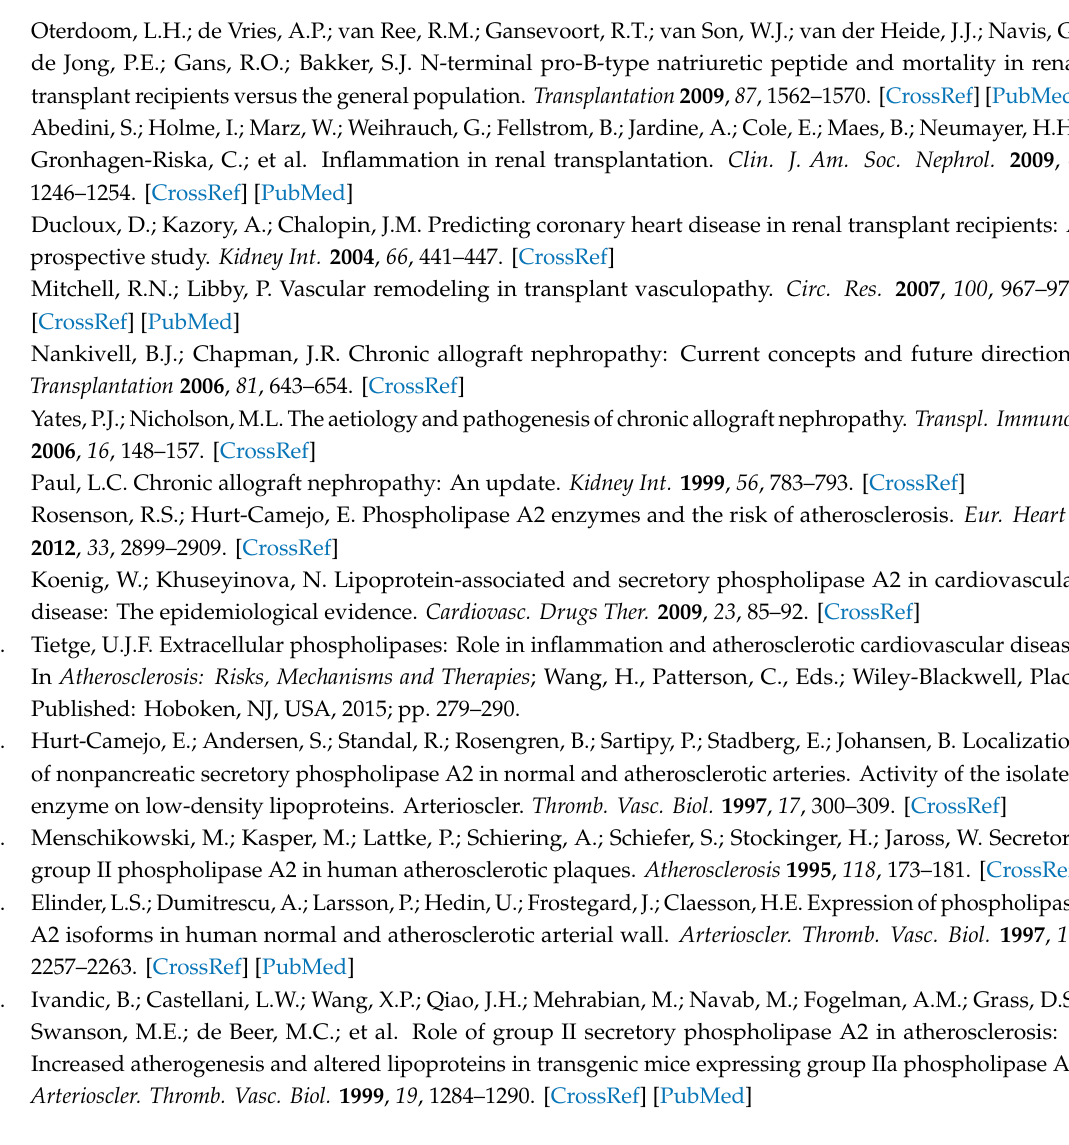
Table S1: Clinical and biochemical characteristics of the end-stage renal disease (ESRD) patients and controls